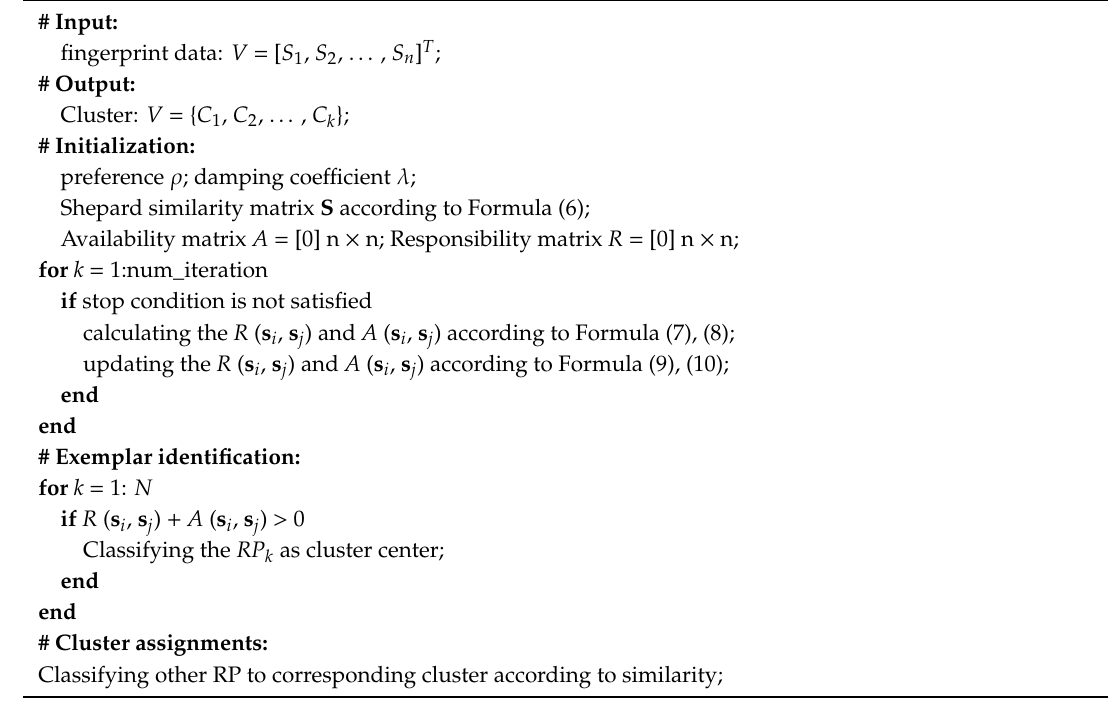
Algorithm 1 . The process of the a ffi nity propagation clustering (APC)